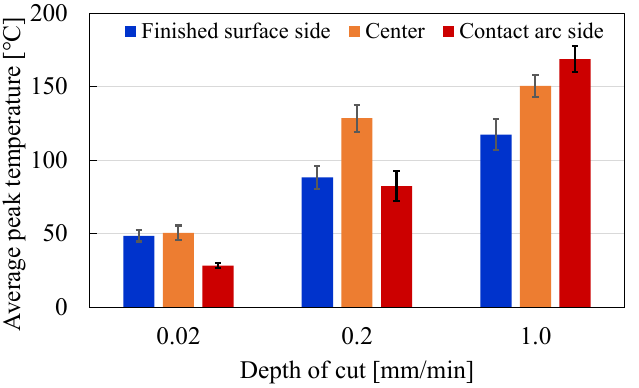
Figure 12. Relationship between the position of measurement area of infrared thermometer and measured average temperature.